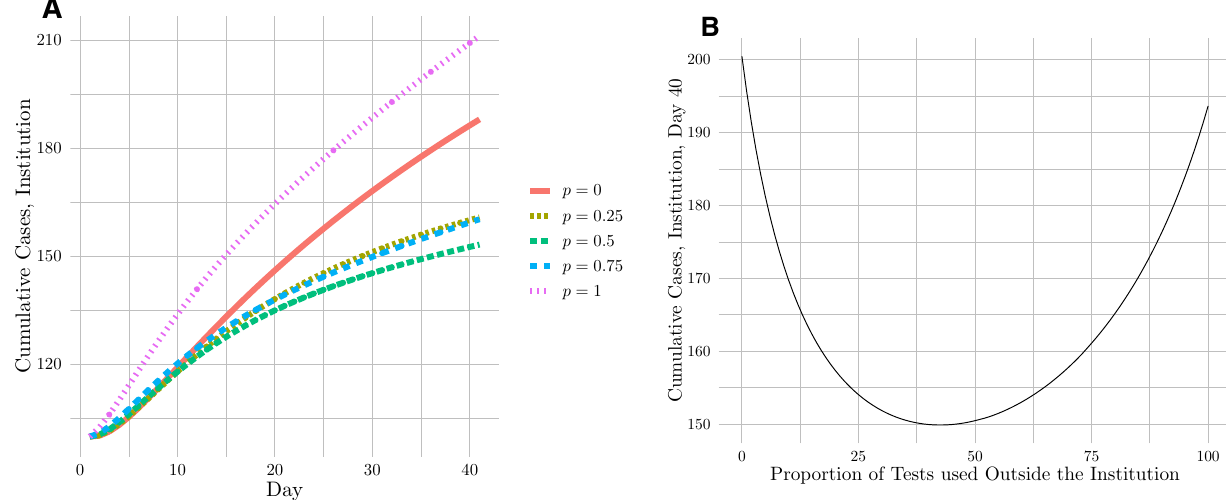
Figure 2. ( A ) Modeled cumulative cases over time at CMU under 5 different proportions p of peripheral testing; ( B ) cumulative cases on day 40 as a function of the proportion of tests deployed to the periphery, with the minimum at 45% peripheral